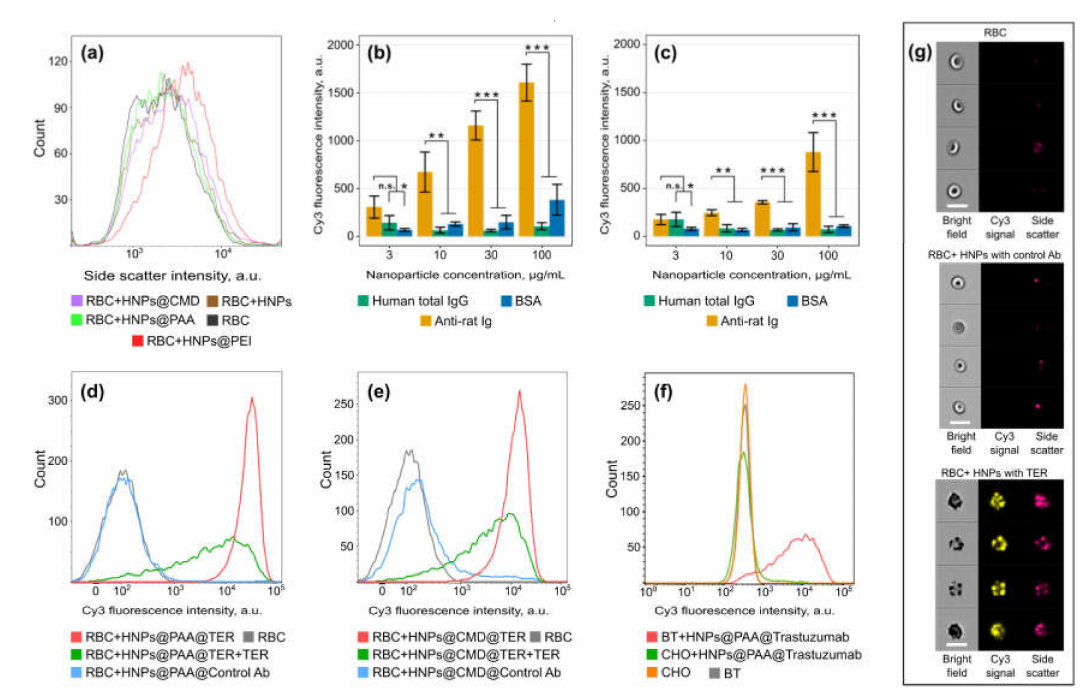
Figure 4. Flow cytometry and fluorescent immunoassay results. ( a ) Interaction between erythrocytes (RBCs) and coated HNPs, higher side scattering indicates stronger interactions; ( b ), ( c ) Binding of bovine serum albumin (BSA), and anti-rat Ig, adsorbed on polystyrene, the data are plotted as mean ± standard deviation ( n = 3); ( d ), ( e ) Imaging flow cytometry analysis of the interaction between distribution obtained in the TER-119 monoclonal antibody (TER)-containing incubation mixture; ( f ) Flow cytometry analysis of the interaction of BT-474 (HER2 / neu-positive) and CHO (HER2 / neu-negative) cells with HNPs@PAA@Trastuzumab-Cy3; ( g ) Images of an interaction between RBCs and two types of polyacrylic acid sodium salt (PAA)-coated nanoparticles, conjugated with the RBC-binding and RBC-nonbinding antibodies (in bright field, Cy3-channel and in side scatter channel). The scale bar is 10 µ m. Significance levels were calculated using unpaired one-tailed t-test (* p < 0.05; ** p < 0.01; *** p < 0.001; n.s. p >